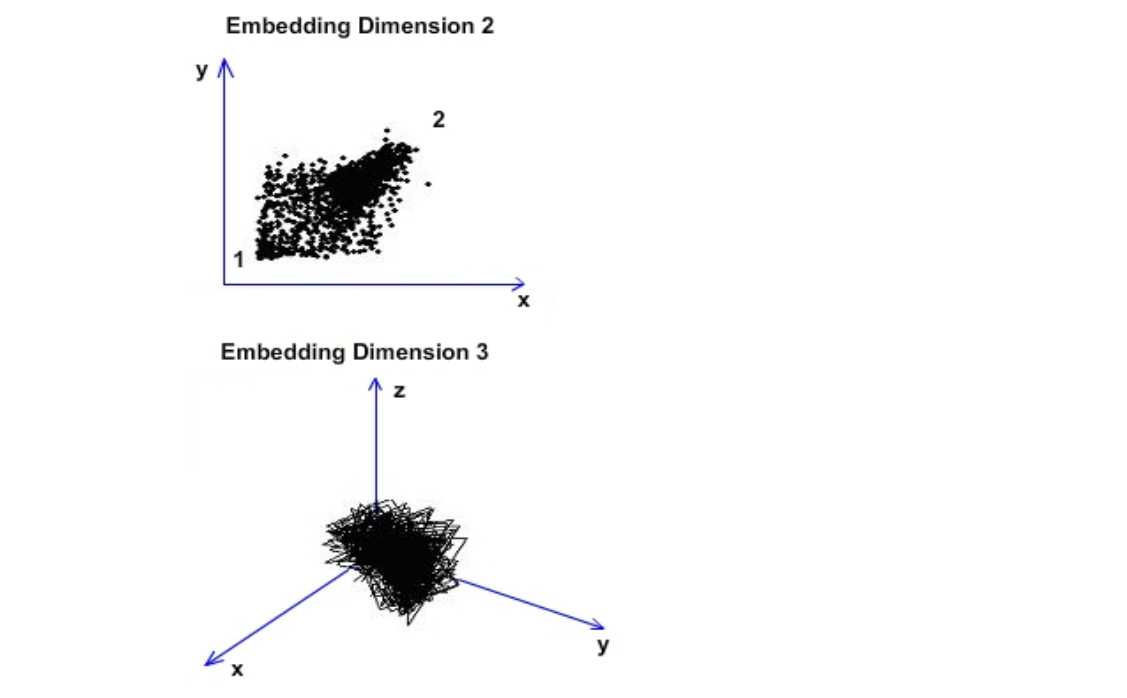
Figure 2. Attractor reconstruction from Figure 1.